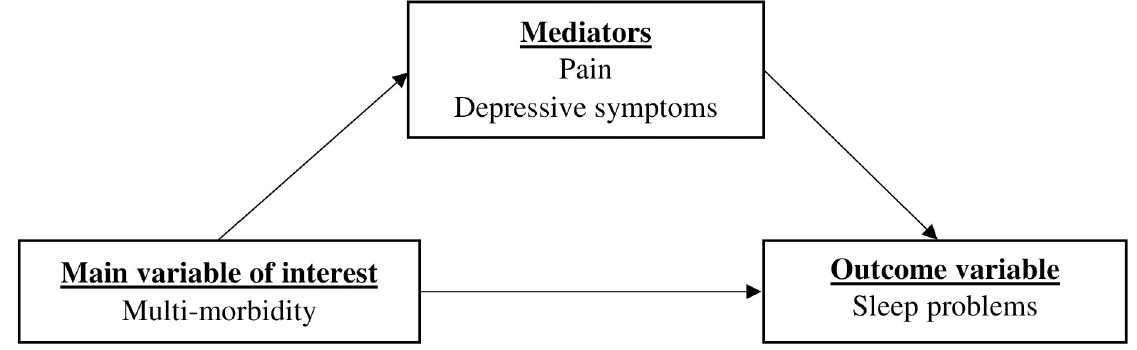
Fig 1. Conceptual model of the